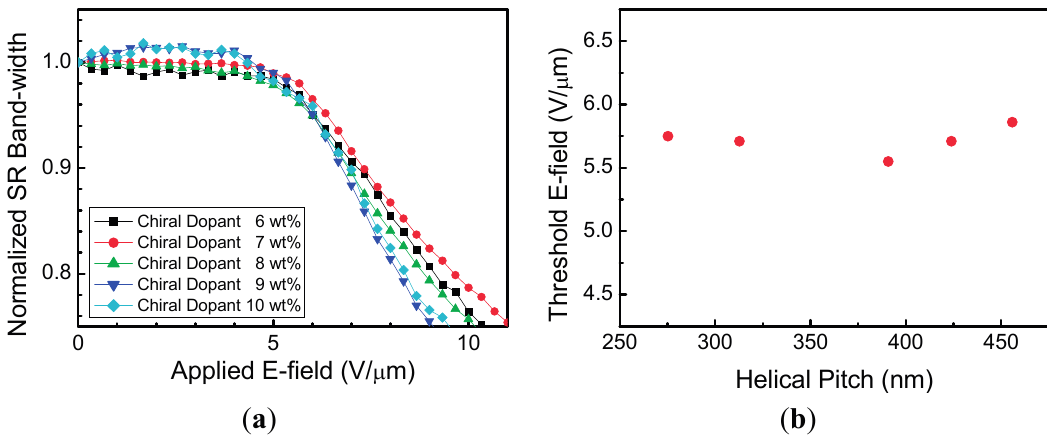
Figure 6. Dependence of the electro-optic response on the chiral dopant concentration of the polymer/ChLC nano-composites after polymerization. ( a ) Normalized selective reflection band-width with respect to the applied electric field at different chiral dopant concentrations; ( b ) Threshold electric field with respect to the helical